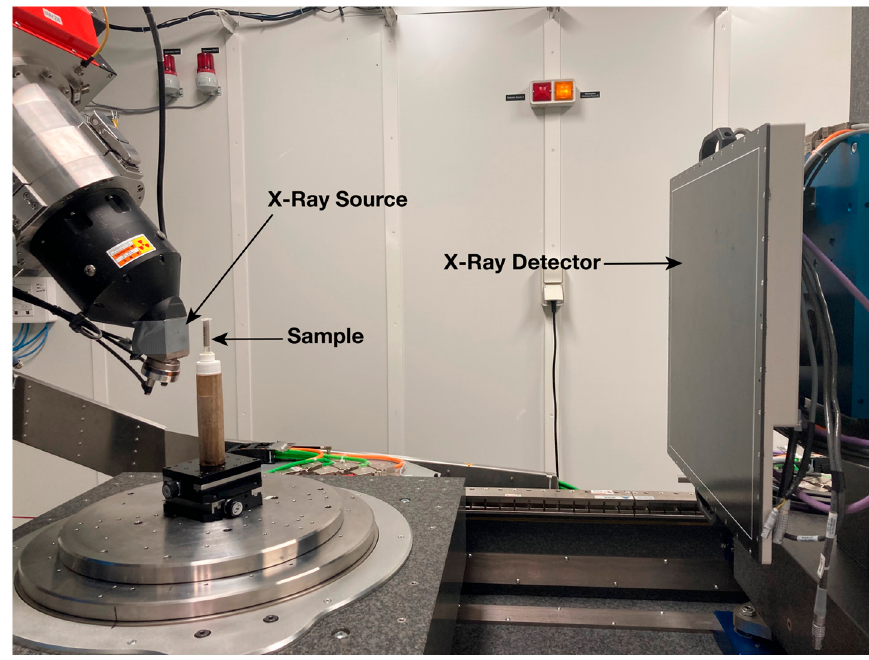
Figure 1. Picture of the X-ray microtomograph setup.